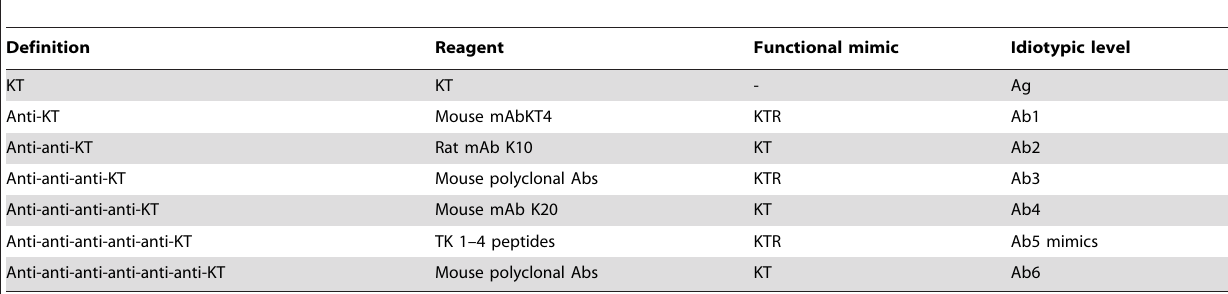
Table 3. Schematic representation of killer toxin (KT)/killer toxin receptor (KTR) functional idiotypic